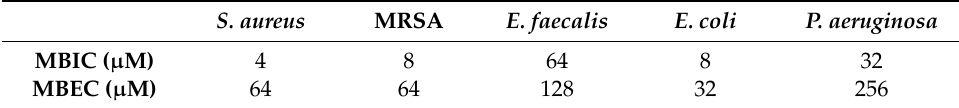
Table 3. The minimum biofilm inhibitory concentrations (MBICs) and minimum biofilm eradication concentrations (MBEC) of Der-PS4.